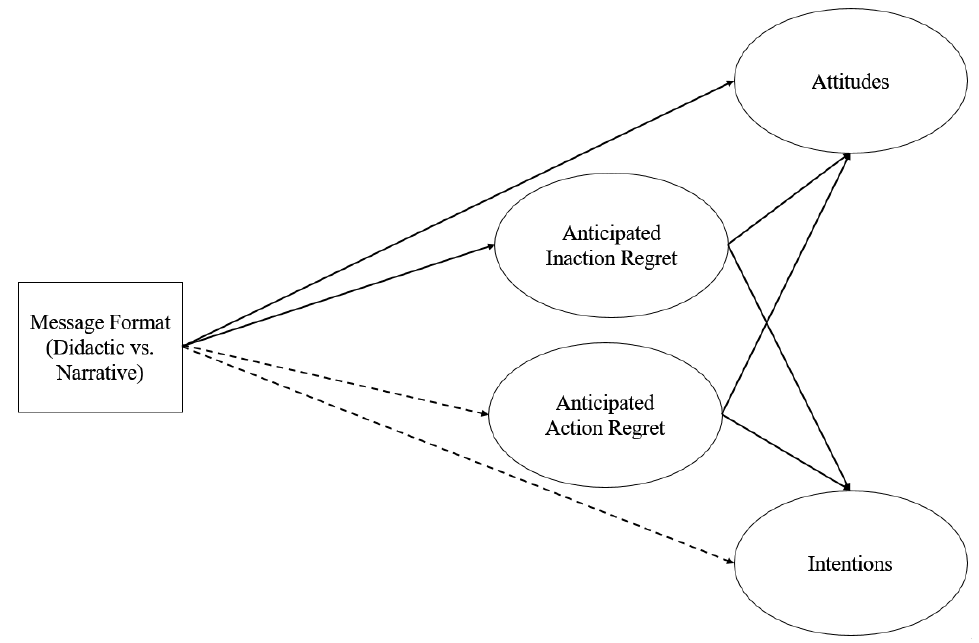
Figure 1. Hypotheses testing results. Solid lines indicate significant effects between variables and dotted lines indicate insignificant effects between variables.